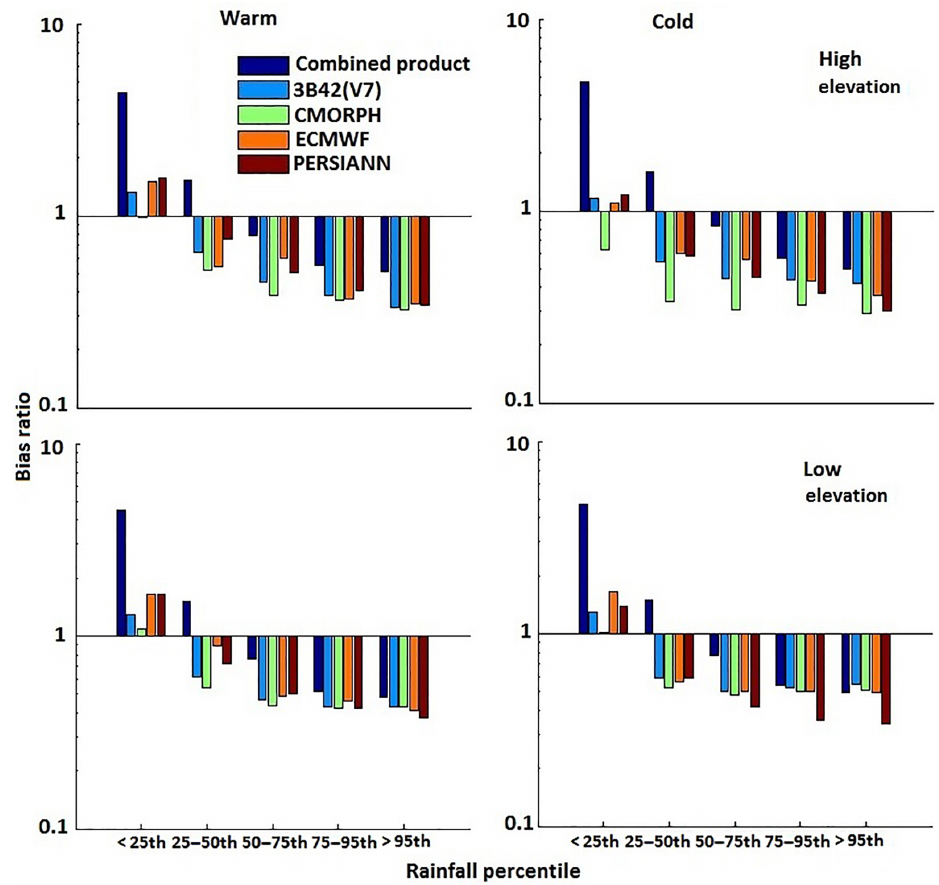
Figure 11. Bias ratio for warm and cold